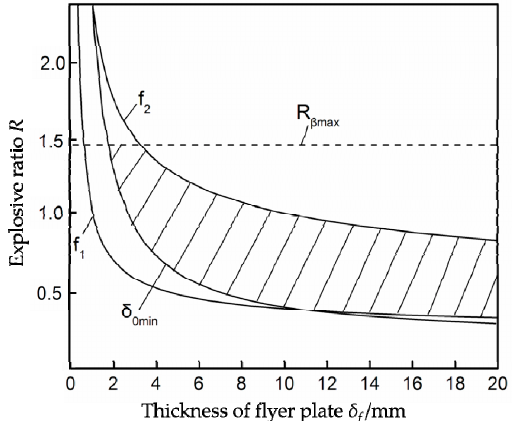
Figure 2. R – δ f welding window of Ti/Al explosive cladding.